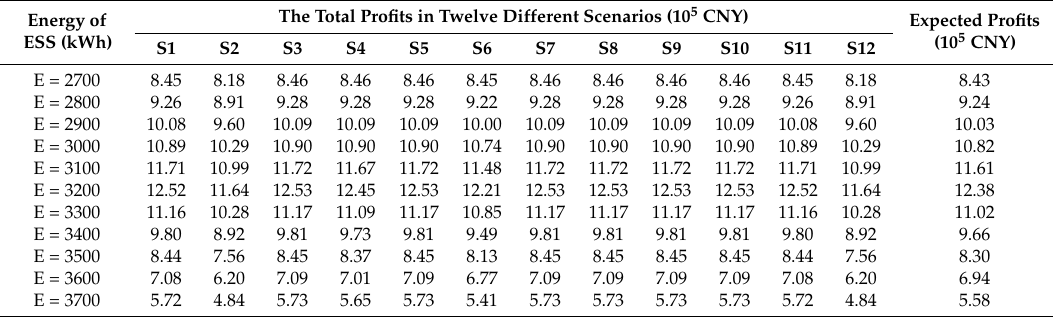
Table 3. The total profits in different scenarios and capacity of energy storage.